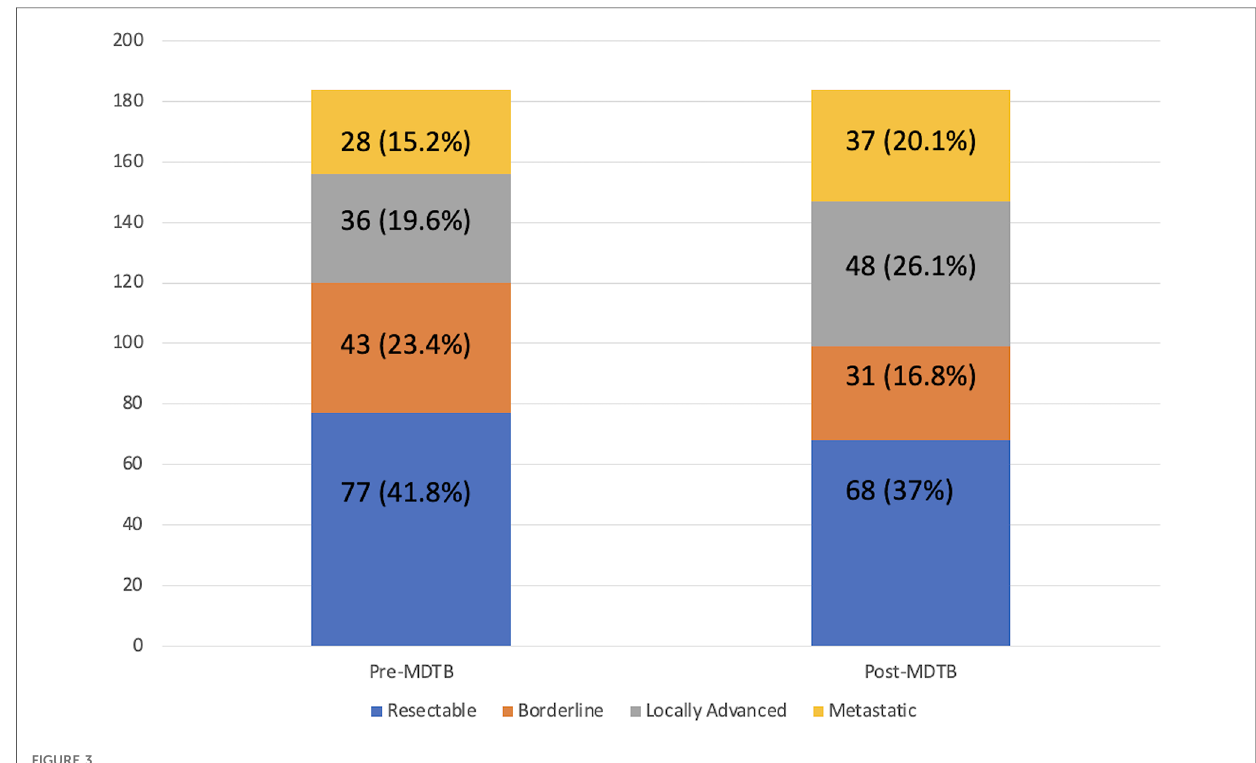
FIGURE 3 Pc resectability change after MDTB